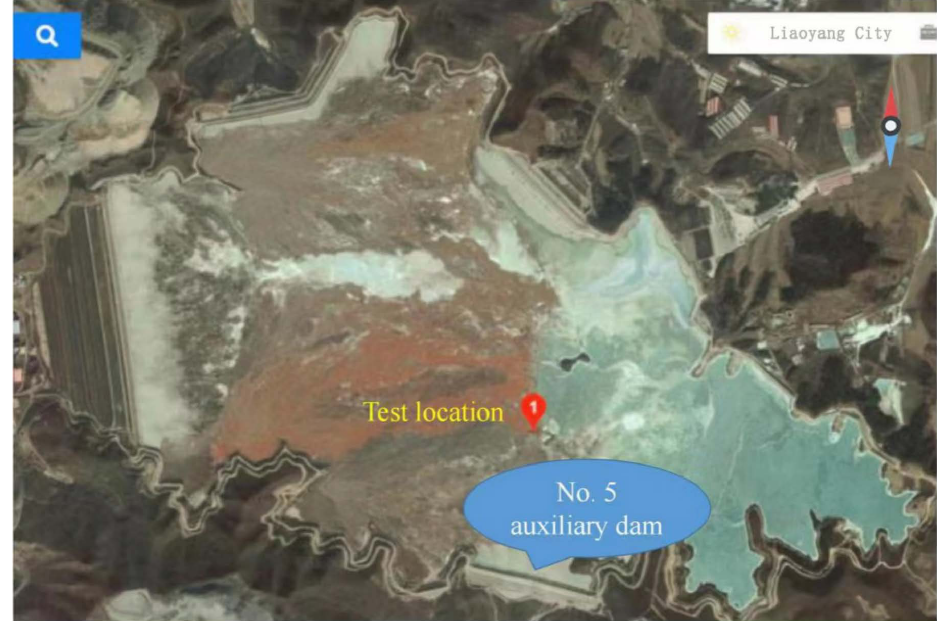
Figure 1. Site test